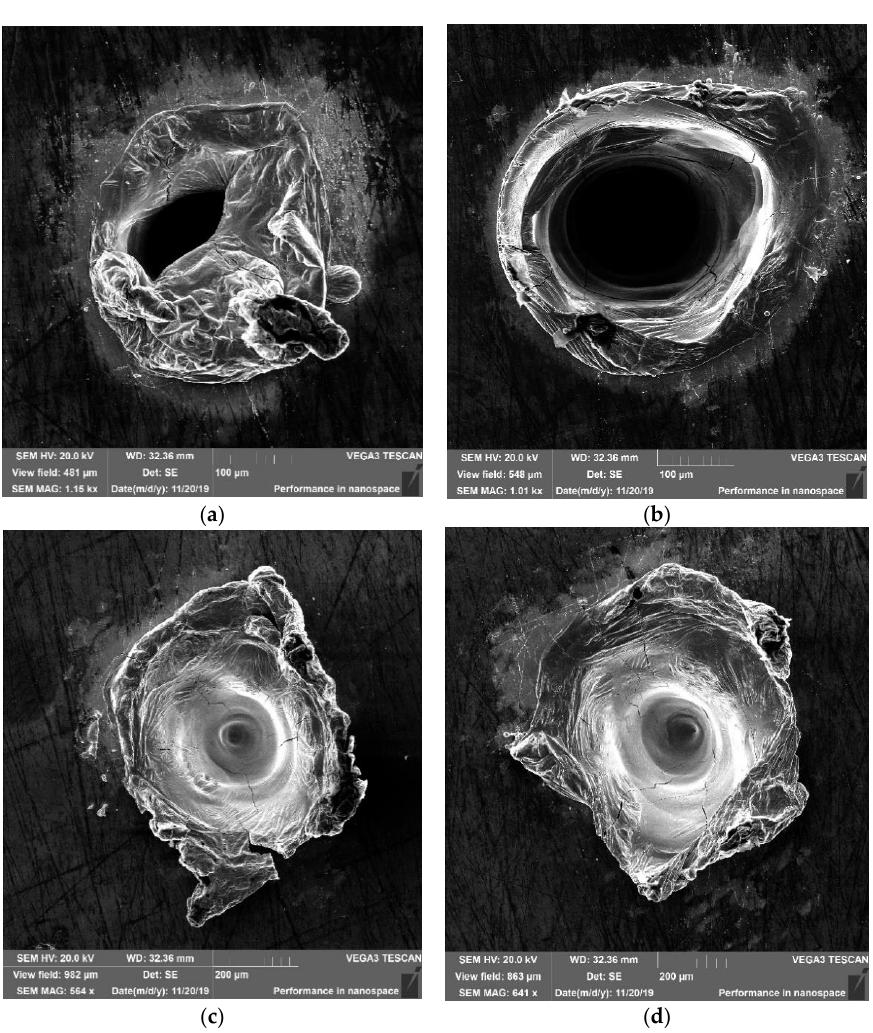
Figure 4. SEM micrographs of the spots on the bulk sample in series I (left) and series II (right): ( a , b ) — spots No. 3 and 12, ε = 32 .0 J·cm −2 ; ( c , d ) —spots No. 2 and 13, ε = 27 .8 J·cm −2 . ( a , b )—spots No. 3 and 12, ε = 32.0 J · cm − 2 ; ( c , d )—spots No. 2 and 13, ε = 27.8 J · cm − 2